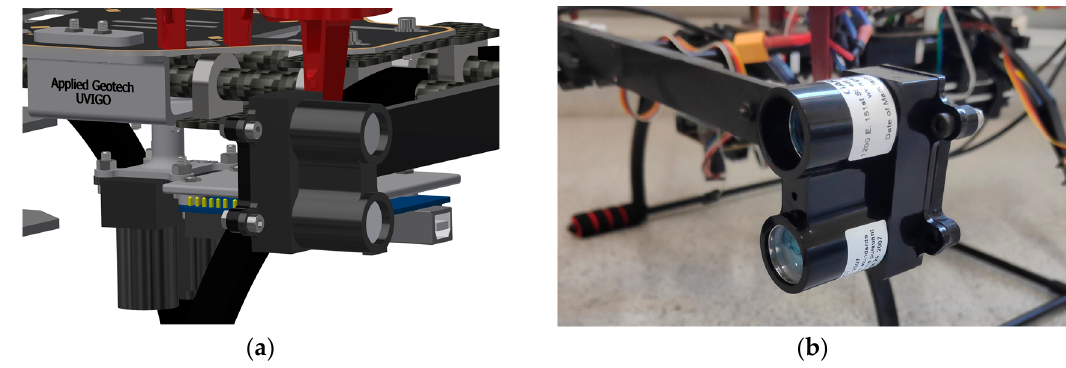
Figure 4. LiDAR sensor used in the designed payload. ( a ) CAD design. ( b ) System photograph.